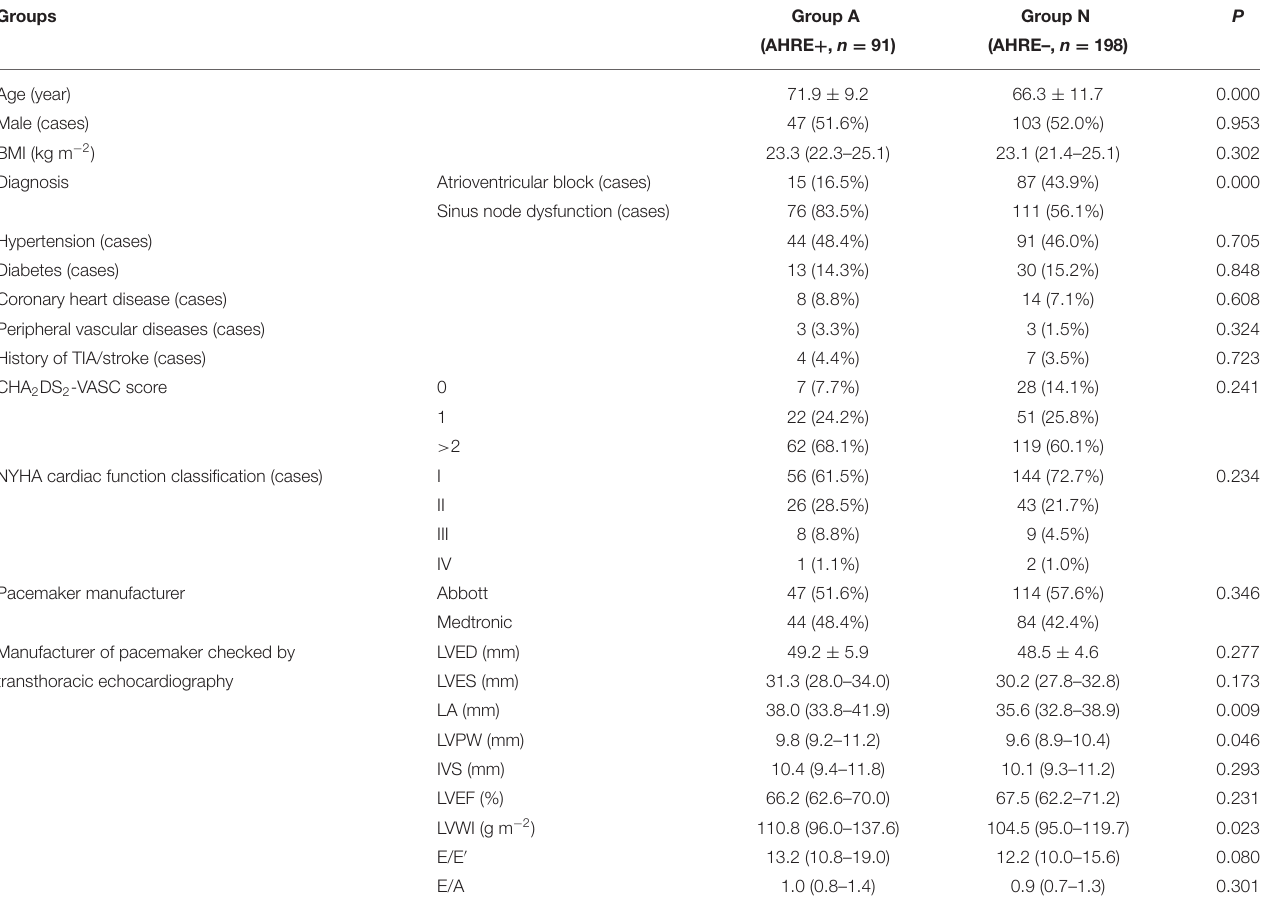
TABLE 1 | Comparison of baseline data of two groups before PPM implantation.